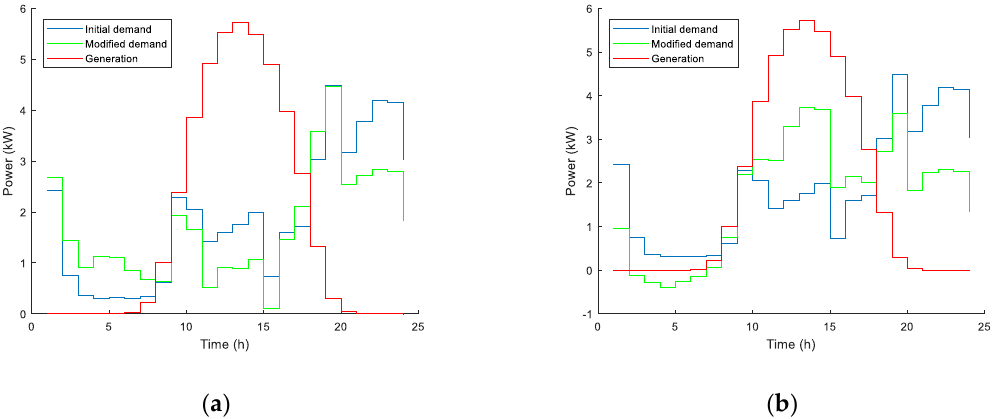
Figure 7. Generation, demand and modified demand hourly power curves of the whole microgrid, during scheduled 24 h: ( a ) COF; ( b ) MOF.